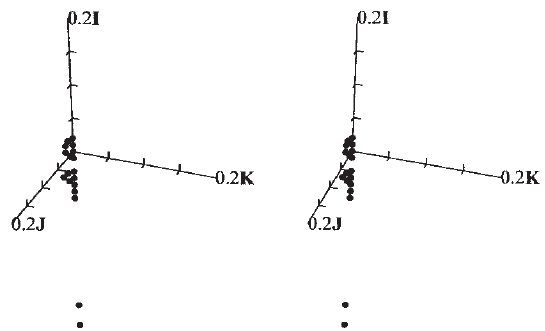
Figure 2. Scatter plot of 50 measurements of refractive state of a test eye taken two months after initial measurements. Operator refocused the instrument after each measurement and the instru- ment triggered itself when adequately focused. Length of axes: 0.2 D. For details see